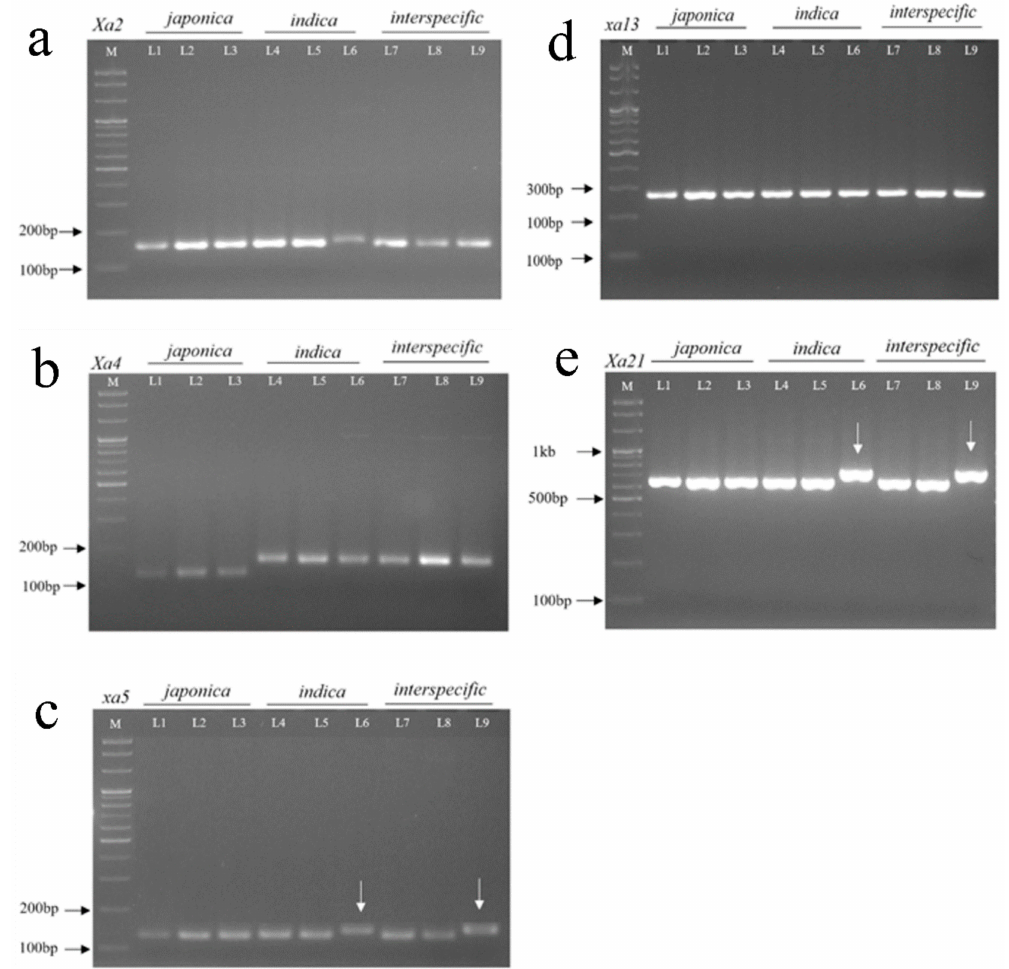
Figure 1. Amplification profile of polymorphic DNA markers tagged with Xa R genes resolved in agarose gel electrophoresis showing polymorphic bands. Five well-known molecular markers linked to dominant Xanthomonas oryzae pv. oryzae ( Xoo) resistance genes in rice. ( a ) Xa2 , ( b ) Xa4 , ( c ) xa5 , ( d ) xa13, and ( e ) Xa21 were amplified by PCR from the genomic DNA of rice cultivars and separated on gel electrophoresis and visualized under UV-light in a gel documentation system. Expected banding sizes for resistant alleles are as follows: Xa2 (154 bp), Xa4 (150 bp), xa5 (227 bp), xa13 (450 bp), Xa21 (950